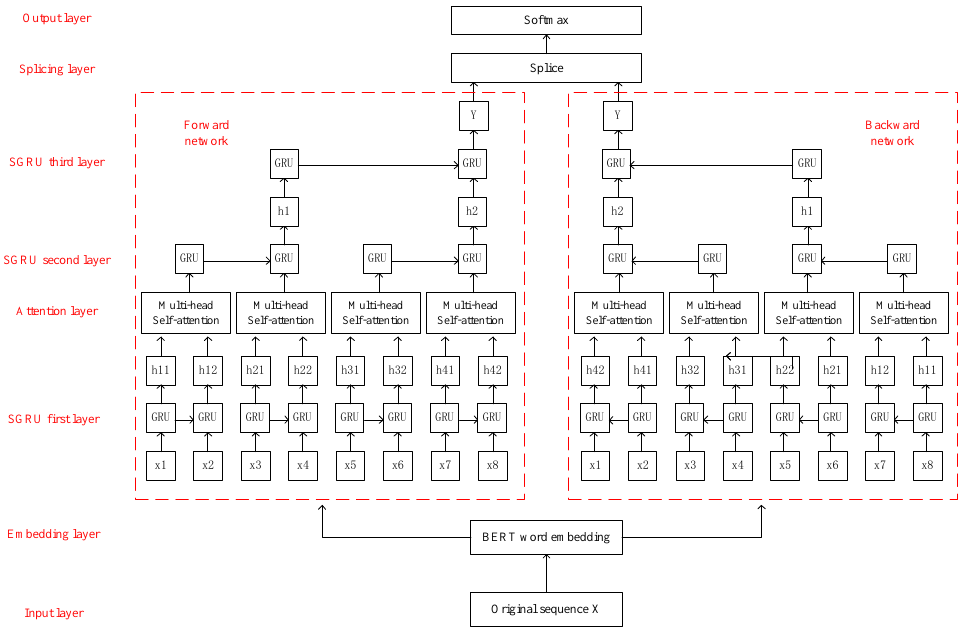
Figure 6. Sliced Bi-GRU classification model based on the Multi-head Self-Attention mechanism. It can be seen from Figure 6 that the original sequence X is used as the input informa- tion of the model input layer, which can be expressed as [ x 1 , x 2 , . . . x T ].